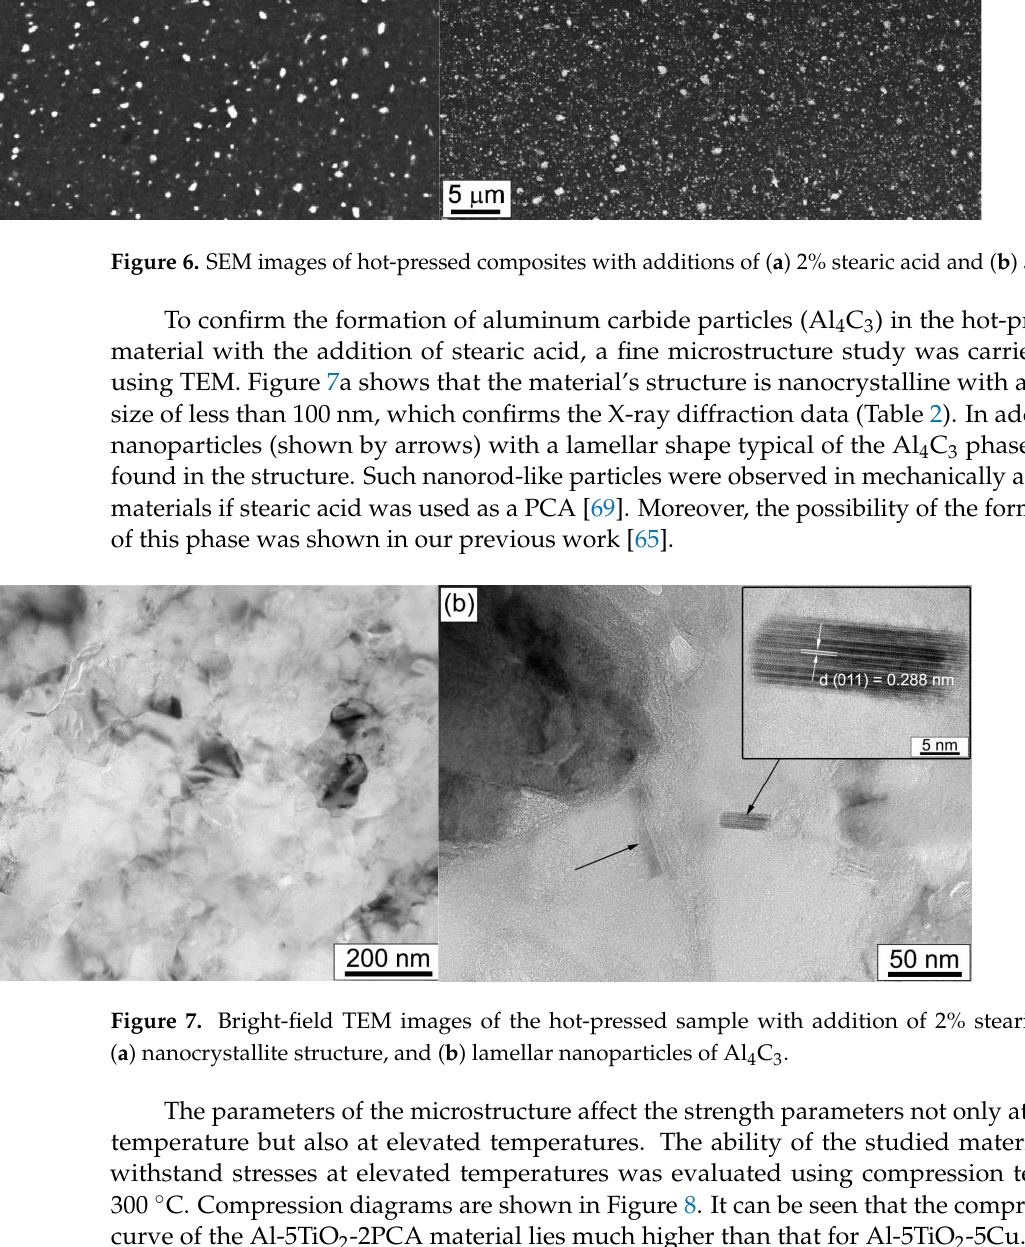
Figure 8. Compression stress-strain curves of the hot-pressed materials in different states at 300 °C. The low thermal stability of the material with the addition of copper is associated with the low strengthening efficiency of Al 2 Cu stable phase dispersoids precipitating at the pressing temperature. In order to form reinforcing particles of metastable modifica- tions typical of Al-Cu alloys, the hot-pressed Al-5TiO 2 -5Cu material was subjected to quenching and subsequent aging in conventional mode (540 °C, 5 h + 180 °C, 8 h). However, the strength indicators of the aged material with the addition of copper turned out to be even lower than those for the hot-pressed one. This is due to a significant coarsening of the grains due to exposure to a high quenching temperature, with the av- erage grain size reaching 231 nm. Thus, the grain size contributes more to the strength at elevated temperatures than the size and shape of the Al 2 Cu dispersoids. Furthermore, the